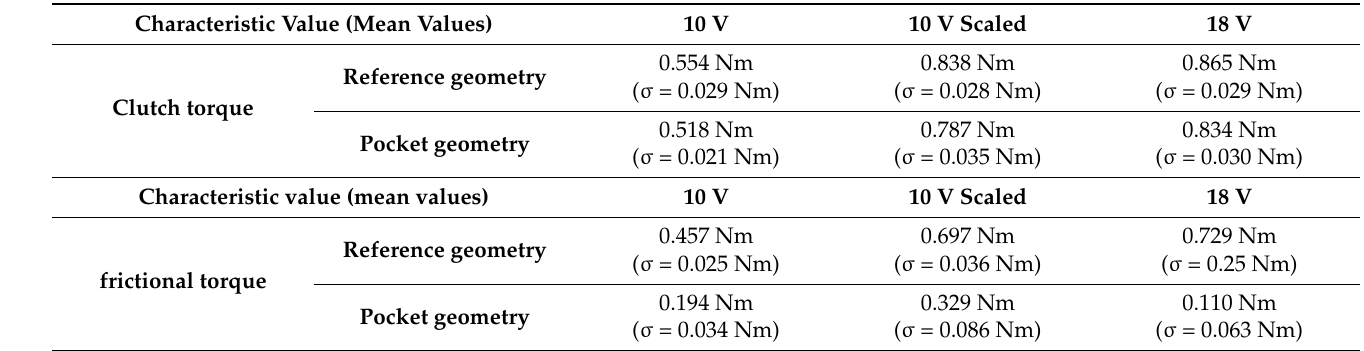
Table 3. Parameters for the evaluation of geometry variants. Mean values of the clutch torque and frictional torque were determined from 21 test repetitions in each case.